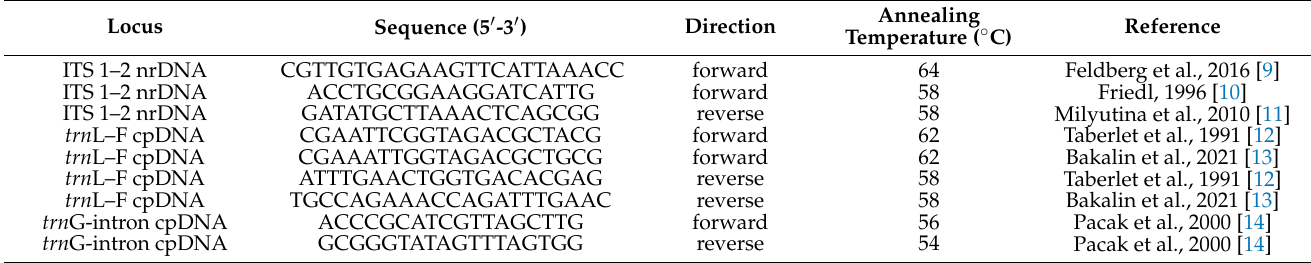
Table 2. Primers used in polymerase chain reaction (PCR) and cycle